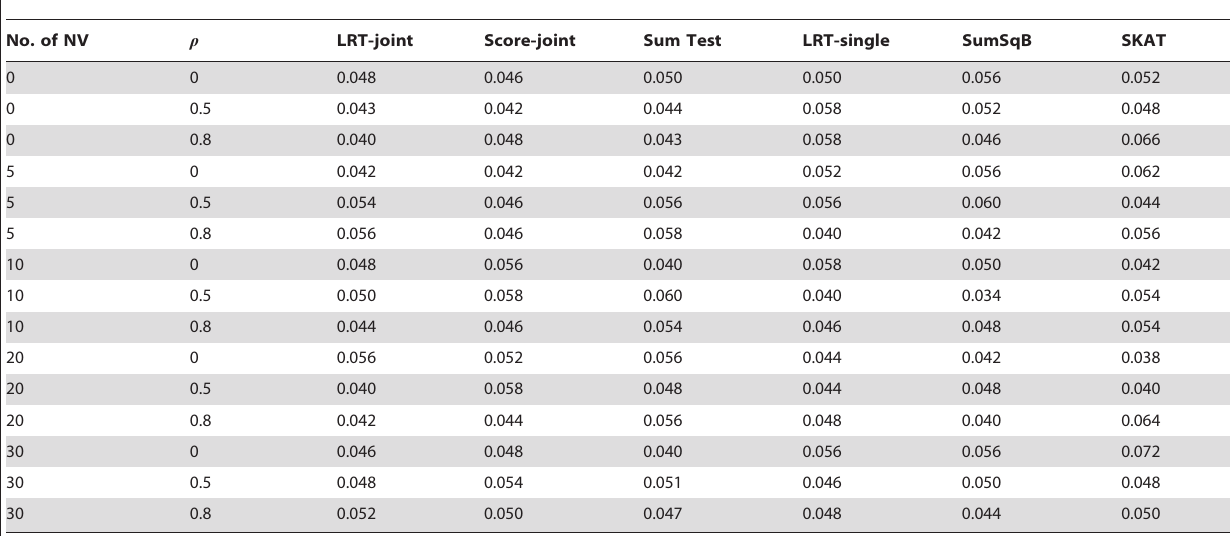
Table 2. Type I error rate for all tests: continuous trait, a ~ 0 : 05